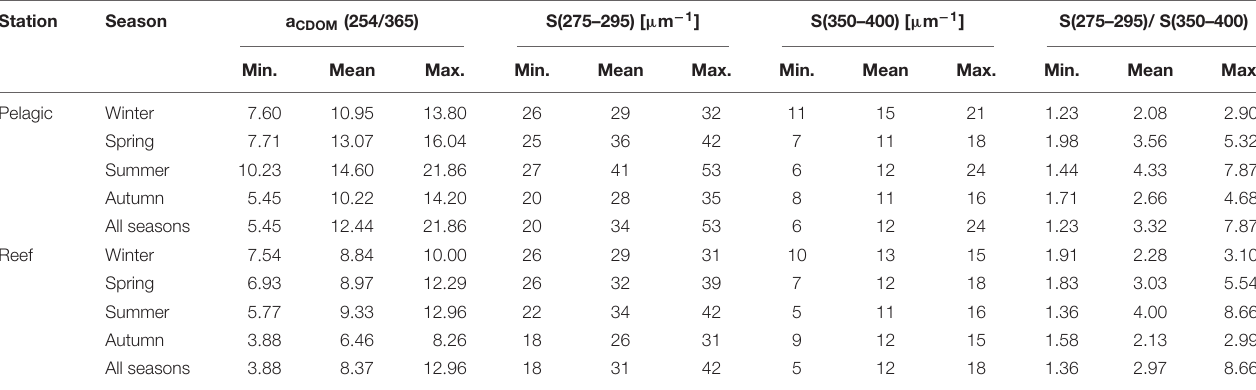
TABLE 2 | Ratio of absorption coefficients at 254 and 365 nm [a CDOM (254/365)], the slopes of the a CDOM ( λ ) spectra in the regions 275–295 nm [S ( 275 − 295 ) ] and 350–400 nm [(S ( 350 − 400 ) ], and the ratio of these two slopes [S ( 275 − 295 )/ S ( 350 − 400 ) ], summarized by station and season for the period May 2016 to September 2018. Station Season